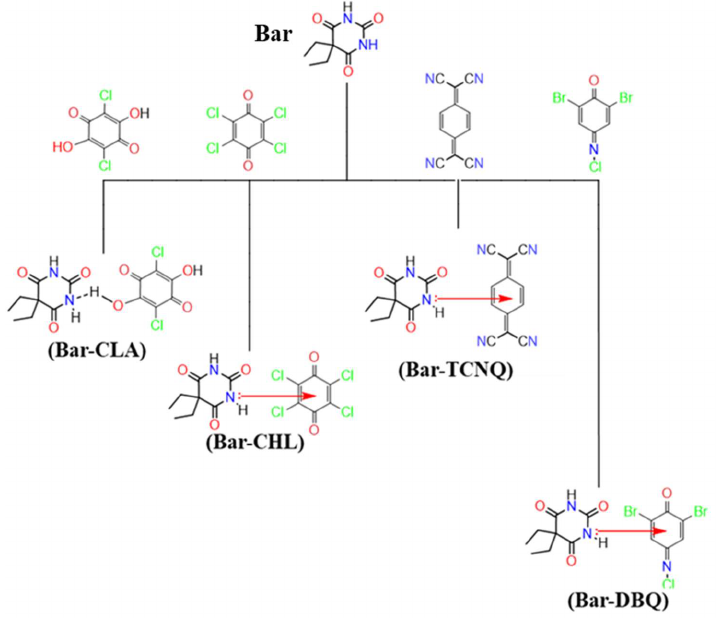
Figure 2. Suggested structures of barbital (Bar) charge transfer complexes.